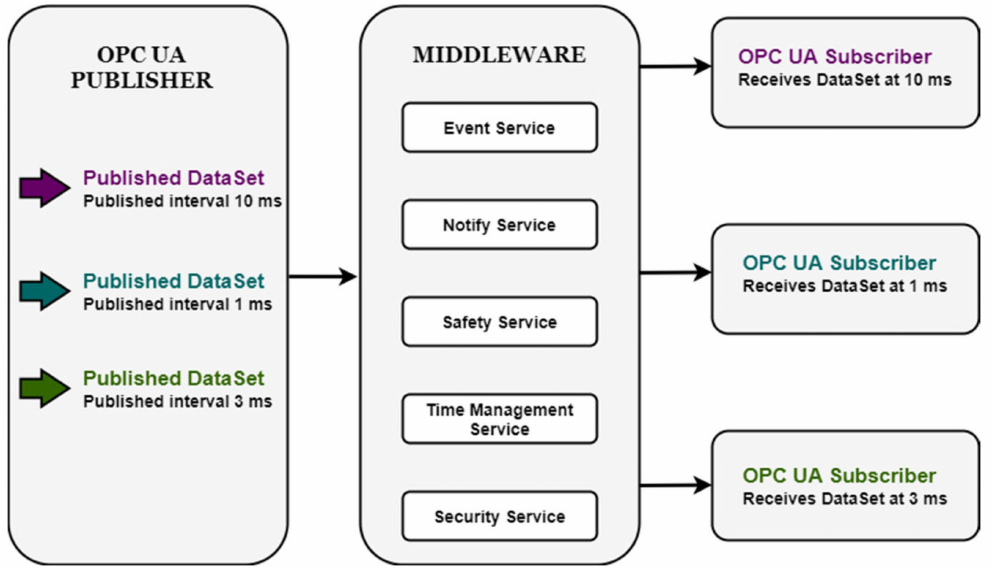
Figure 1. Hypothetical / Proposed Middleware Design with Services, in real time